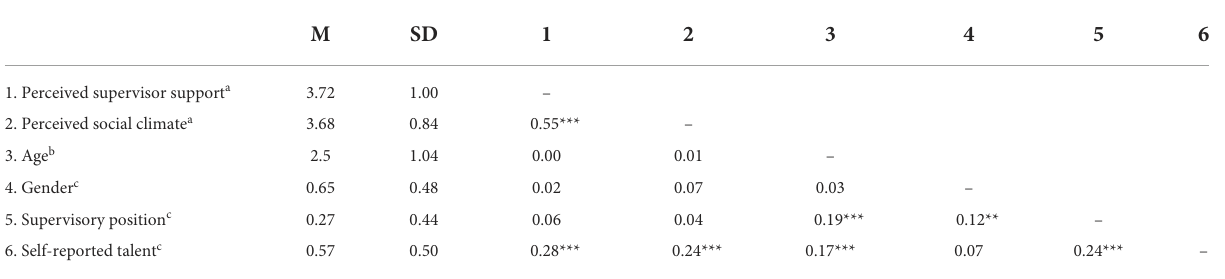
TABLE 1 Descriptive statistics and correlations among study variables ( N =